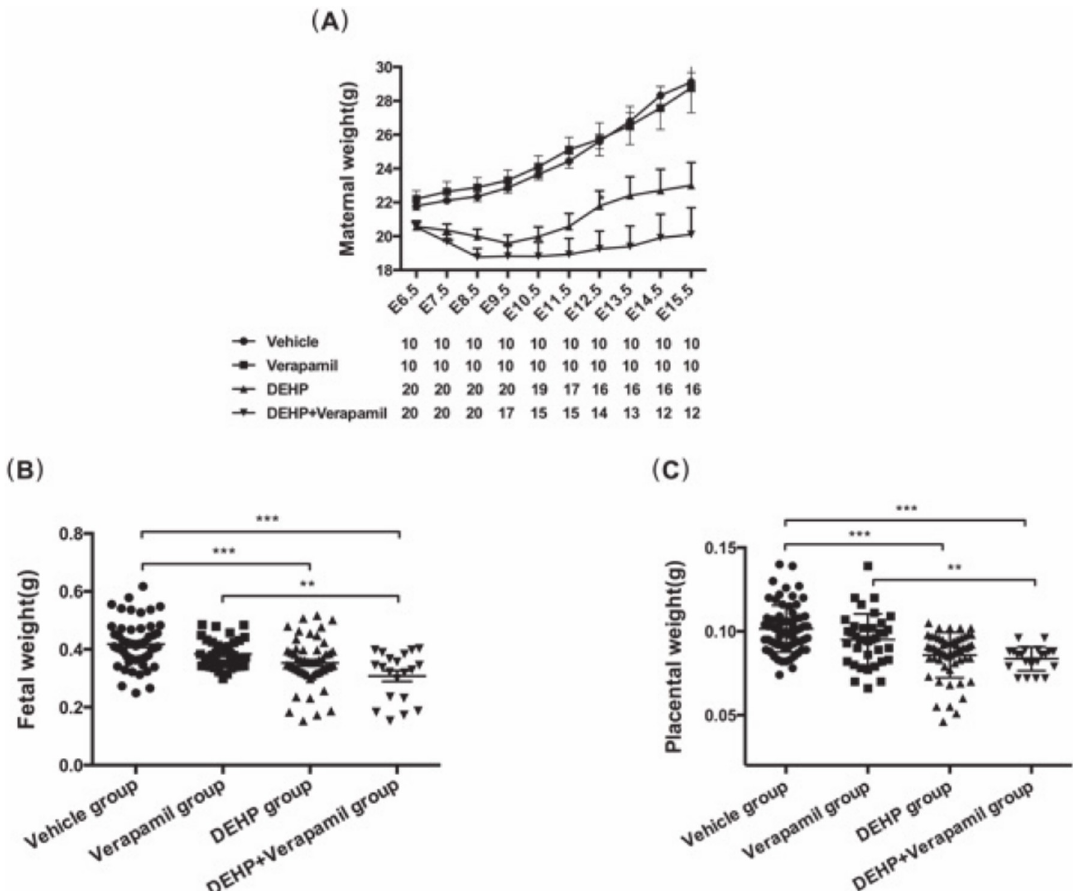
Fig 1. Effect of maternal Di-(2-ethylhexyl)-phthalate (DEHP) and verapamil exposure from E6.5 to E14.5 on maternal bodyweights (A), fetal weights (B) and placental weights (C). Differences among different groups were determined by ANOVA followed by a Student–Newman–Keuls multiple comparisons. N = 10, 15, 20 and 10 for vehicle, 500mg/Kg DEHP, 500mg/Kg DEHP & 3mg/Kg verapamil and 3mg/Kg verapamil group, respectively. Data were expressed as Means ± SEM. � P < 0.05, �� P < 0.01, ��� P < 0.001 in comparison with the verapamil group and the vehicle